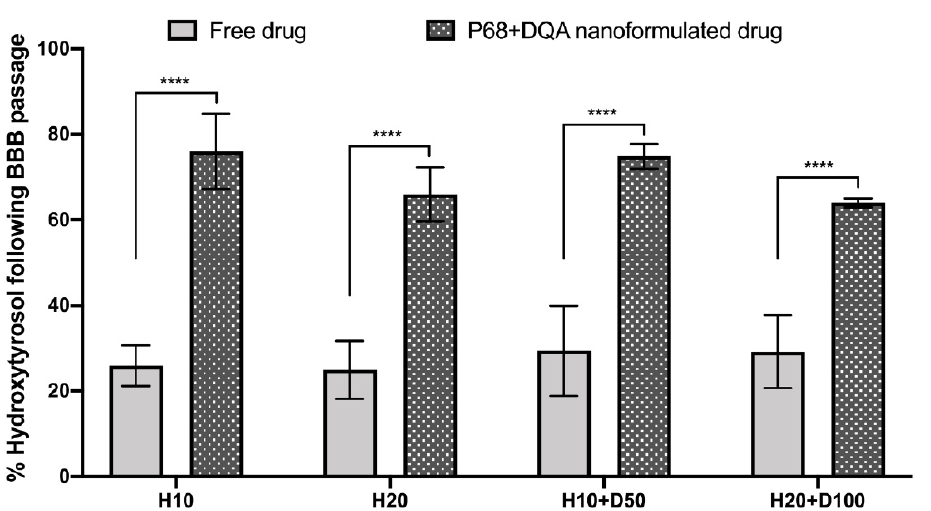
Figure 6. Mean percentage of HT in the basolateral compartment of the hCMEC/D3 Transwell ® system following 60 min treatment with free or P68 + DQA HT (10 and 20 µ M) and combined HT and DFO (10 and 20 µ M HT + 50 and 100 µ M DFO, respectively). Percentage HT = ((absorbance of the basolateral compartment sample − control)/(absorbance of the treatment- control)) × 100, where the absorbance was read at 280 nm and the control was MEM. * represents significance values of nanoformulated drug compared to free drug within the same treatment condition (**** p < 0.0001).